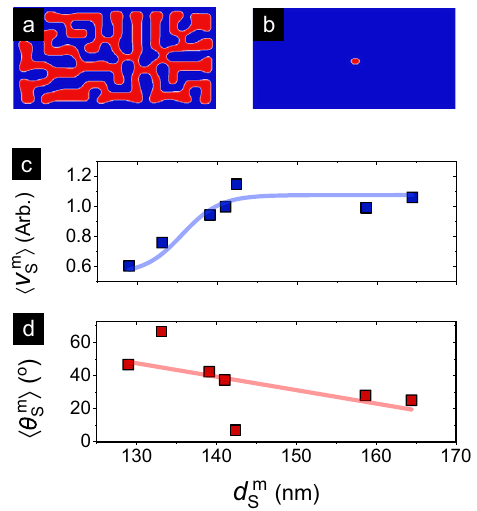
Fig. 5 Micromagnetic simulations of skyrmion size effects. a , b Representative micromagnetic magnetization of a 2 × 4 μ m 2 wire showing a single skyrmion formed upon relaxation at μ 0 H ≃ 85 mT. The grain-free Fig. 6 Particle model simulations of skyrmion size effects. a , b Schematics simulations were performed using stack parameters consistent with of particle model simulations (details in Methods) which examine the experiments (details in Methods). c , d Evolution of micromagnetic dynamics of point-like skyrmion particles (foreground, red) in the presence i ( c ) and average angular de fl ection h θ m i ( d ) simulated average velocity h v m S S of pinning sites with radius R pin (background, blue). Black lines show with d S — extracted from a series of such simulations at a representative representative trajectories of skyrmions. Decreasing R pin within the model J = 9.5 × 10 11 A/m 2 . Solid lines represent sigmoidal ( c ) and linear ( d ) fi ts, (left to right) emulates the effect of increasing d S . c , d Evolution of particle respectively. i ( c ) and average angular de fl ection model simulated average velocity h v p S h θ p i ( d ) with 1/ R ≡ d pin S extracted from a series of particle model S simulations with fi xed